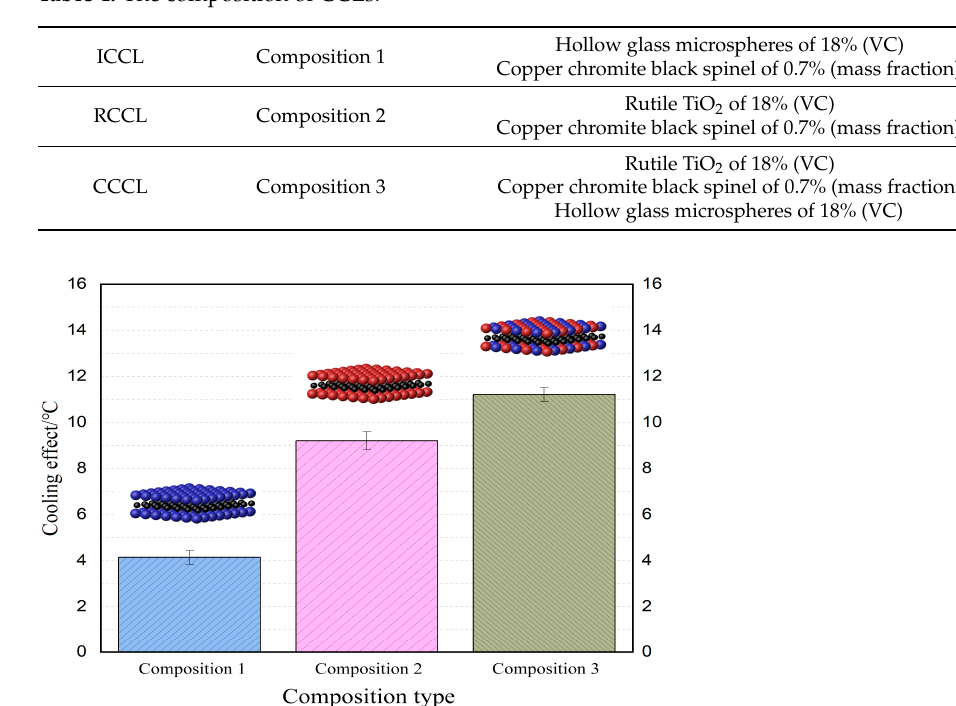
Figure 8. A schematic diagram of CCLs: ( a ) composition 1 (ICCL); ( b ) composition 2 (RCCL); ( c ) composition 3 (CCCL). Table 4. The composition of CCLs.